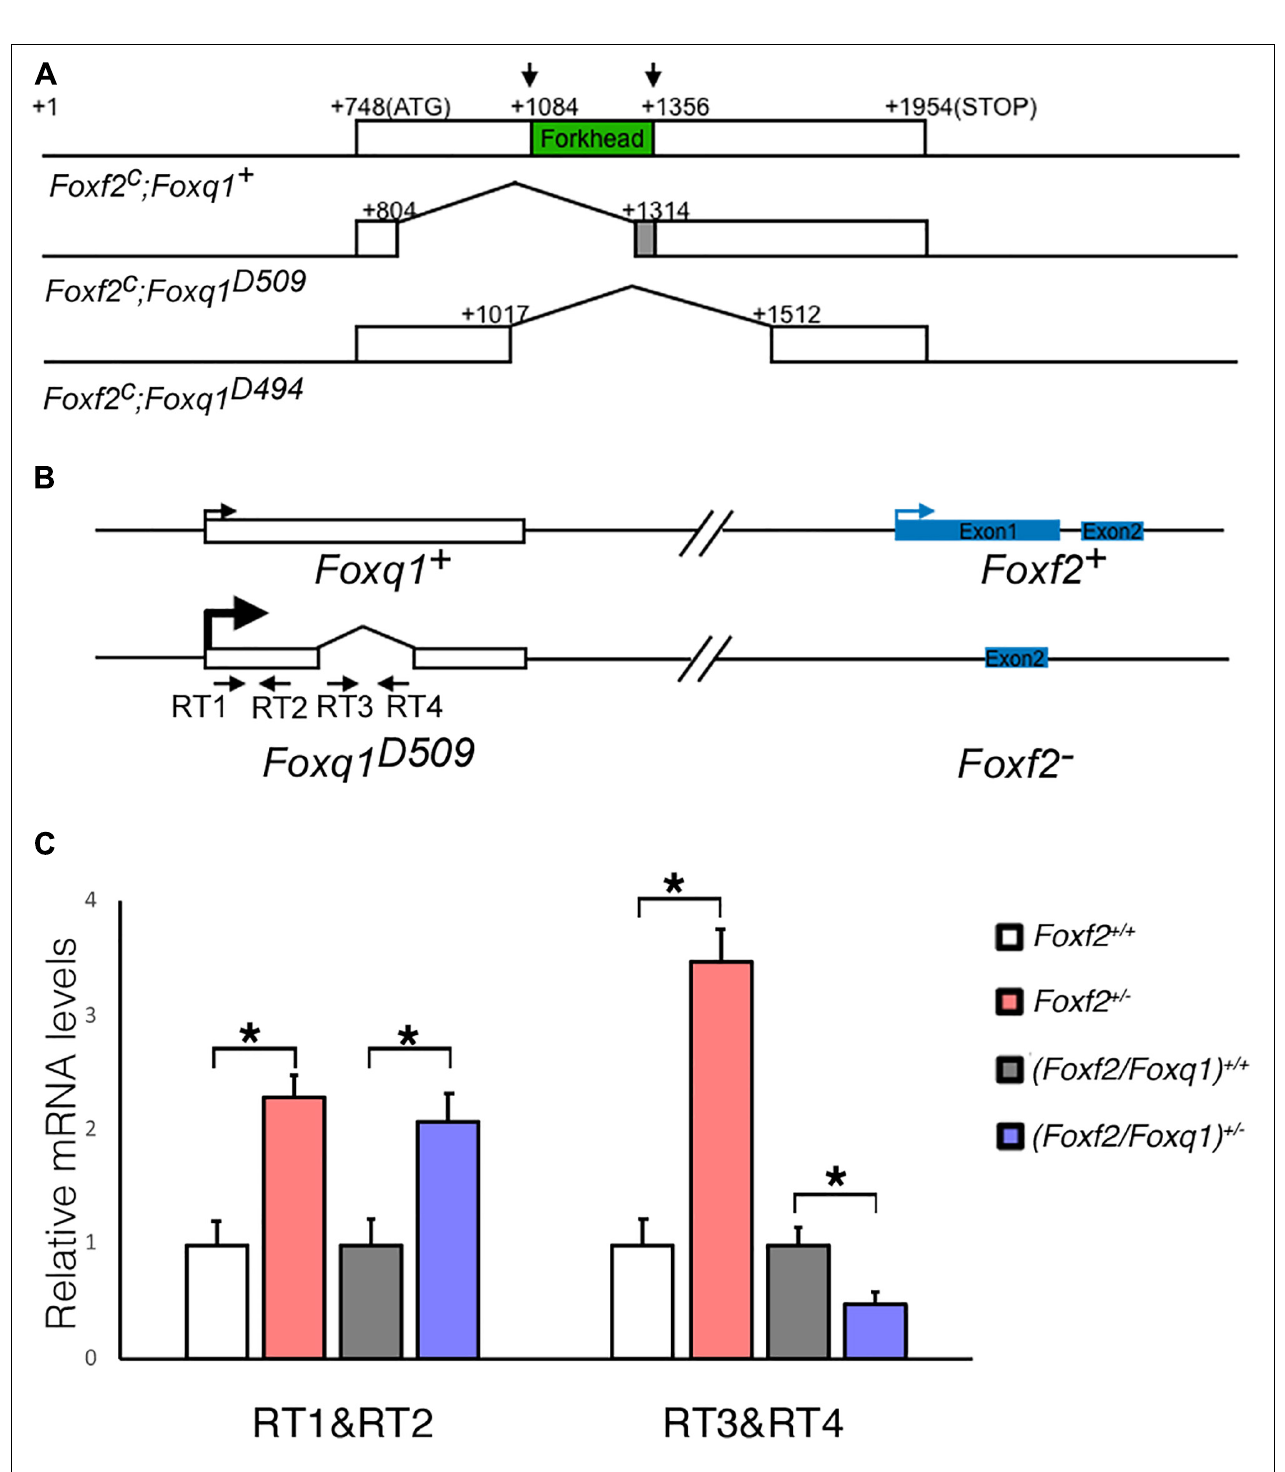
FIGURE 2 | Generation of Foxf2/Foxq1 double mutant mouse. (A) Schematics of the strategy for generating Foxf2 c ; Foxq1 - mice using the CRISPR/cas9 approach. The top row shows the genomic organization of the mouse Foxq1 locus. The coding sequence is boxed with the Forkhead-domain coding region filled in green. The two vertical arrows indicate the positions of recognition sites of the two sgRNAs used for CRISPR genome editing. The second and third rows show the two edited Foxf2 c ; Foxq1 - mouse alleles, Foxf2 c ; Foxq1 D 509 , and Foxf2 c ; Foxq1 D 494 , respectively. (B) Schematics of the strategy for investigating the allele-specific effects of the Foxf2 mutation on the linked Foxq1 gene. A pair of primers (RT1&RT2) was designed to detect the Foxq1 mRNAs expressed from both alleles. Another pair of primers (RT3&RT4) was designed to detect the Foxq1 mRNAs expressed from only the wildtype Foxq1 allele. (C) Real time RT-qPCR analysis of the levels of expression of Foxq1 mRNAs in E13.5 palatal shelves in Foxf2 + / + , Foxf2 + / − , (Foxf2/Foxq1) + / + , and (Foxf2/Foxq1) + / − embryos ( n ≥ 4). * p < 0.05.